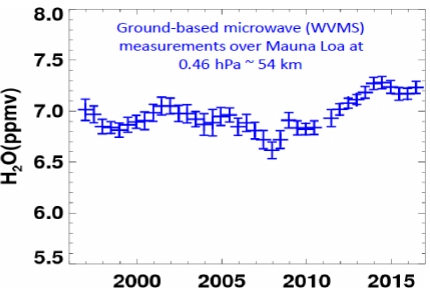
Figure 12. Annual average water vapour mixing ratios at 54km ( ∼ 0.46hPa) over Mauna Loa (19.5 ◦ N, 204.4 ◦ E). Symbols are shown for January–December and July–June; the seasonal cycle has been removed. Thus, each measurement is included in two annual anomalies. Mixing ratios are retrieved from ∼ weekly integrated spectra; error bars represent the standard deviation of the mean rel- ative to a seasonal